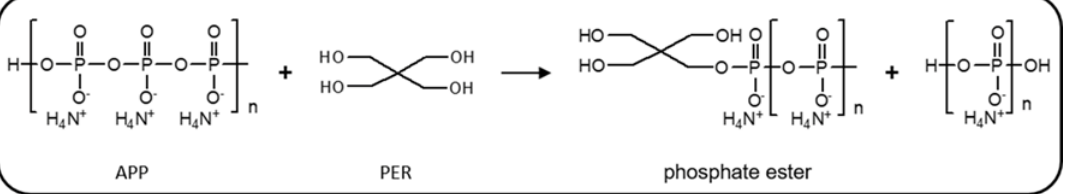
Figure 1. Reaction between ammonium polyphosphate (APP) and pentaerythritol (PER). Adapted from Camino et al. [14].